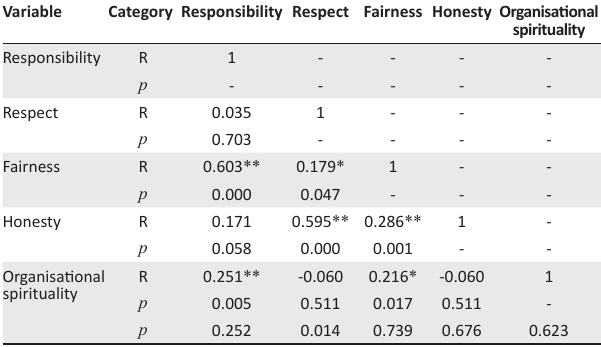
TABLE 2: Pearson’s product–moment correlation coefficient results for the variables measured.